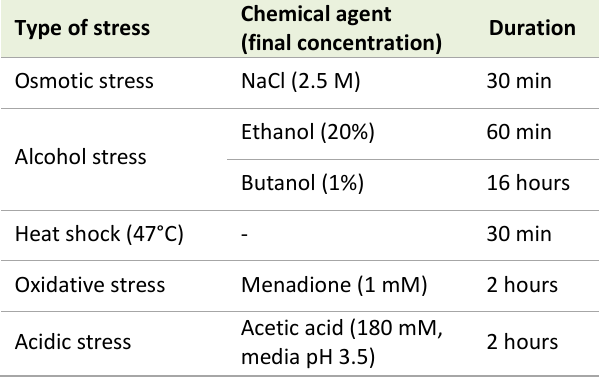
TABLE 1. Types of stresses used in this study.